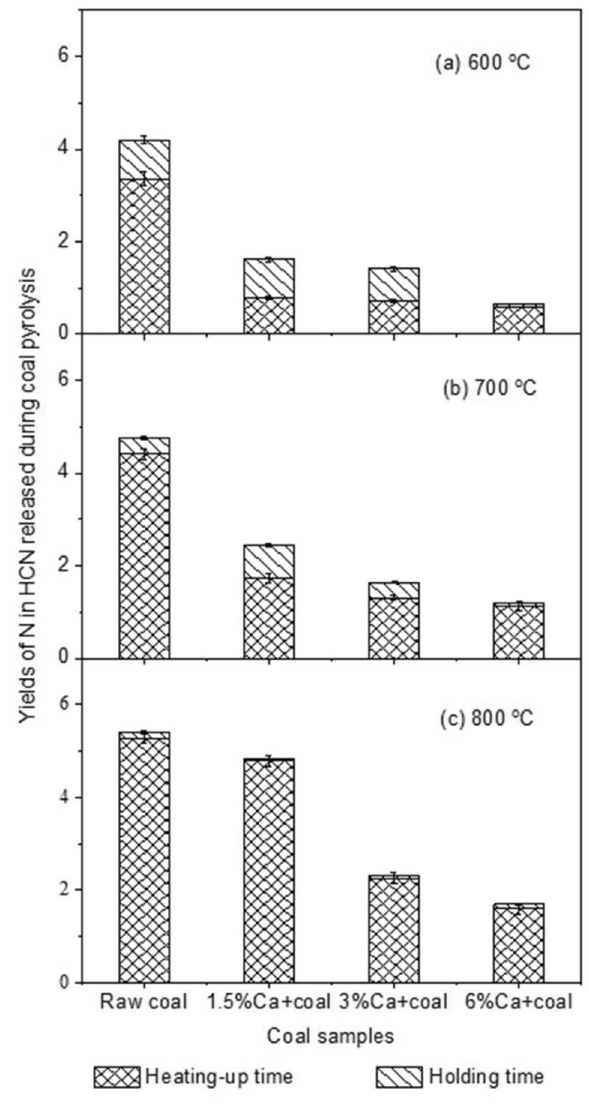
Fig. 3 The yields of HCN during the pyrolysis of raw coal and coal samples loaded with different contents of calcium at the heating-up time and holding time at different